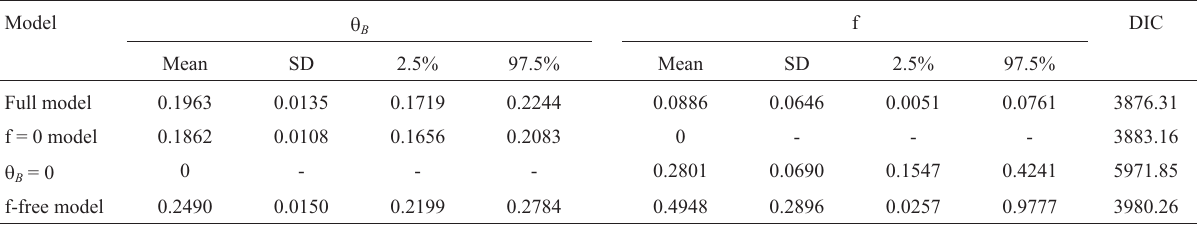
Table 4 - Genetic differentiation calculated among populations of R. tanguticum using different Bayesian approaches.